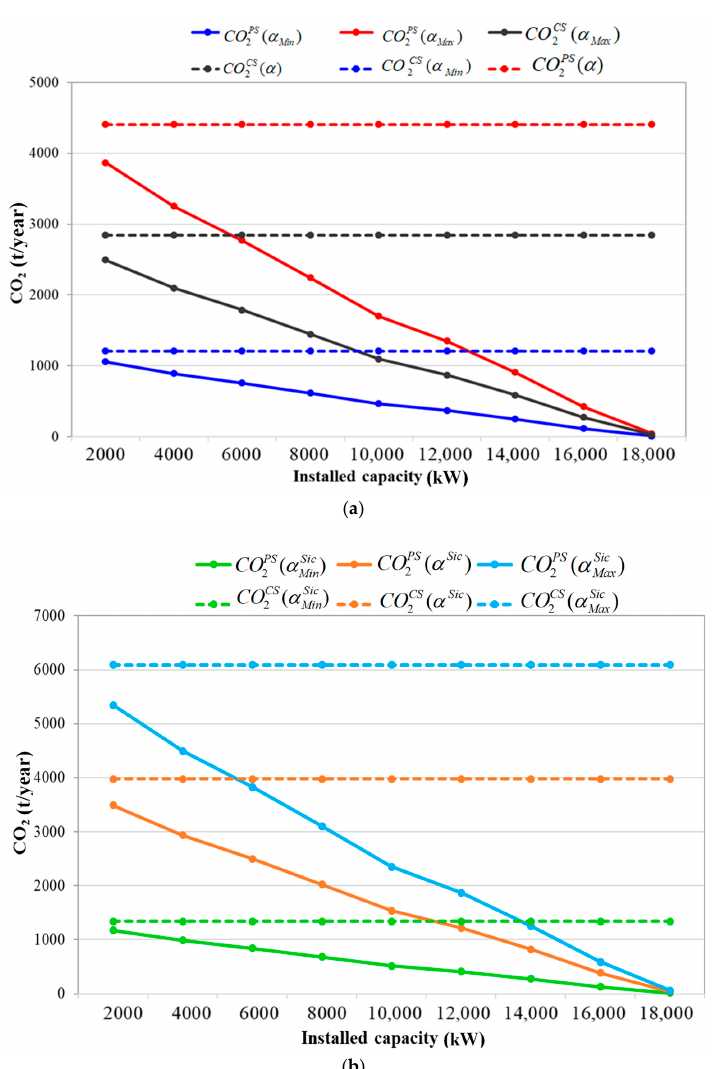
Figure 9. CO 2 emissions for PS and CS considering minimum, maximum and average values of emission factor for electricity referred to Italy ( a ) and Sicily zone ( b ) as a function of installed PV power in Sc#2.